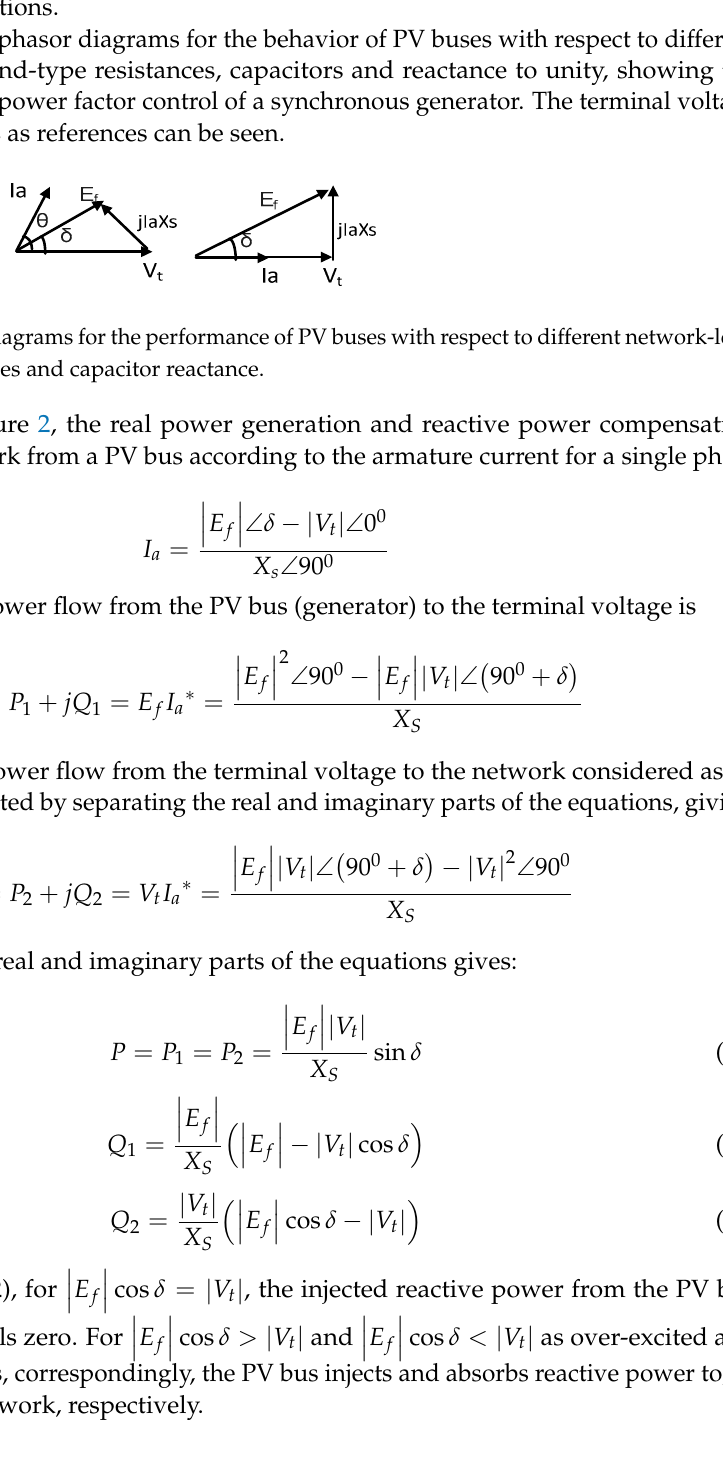
Figure 1. The single power network diagram including a PV.